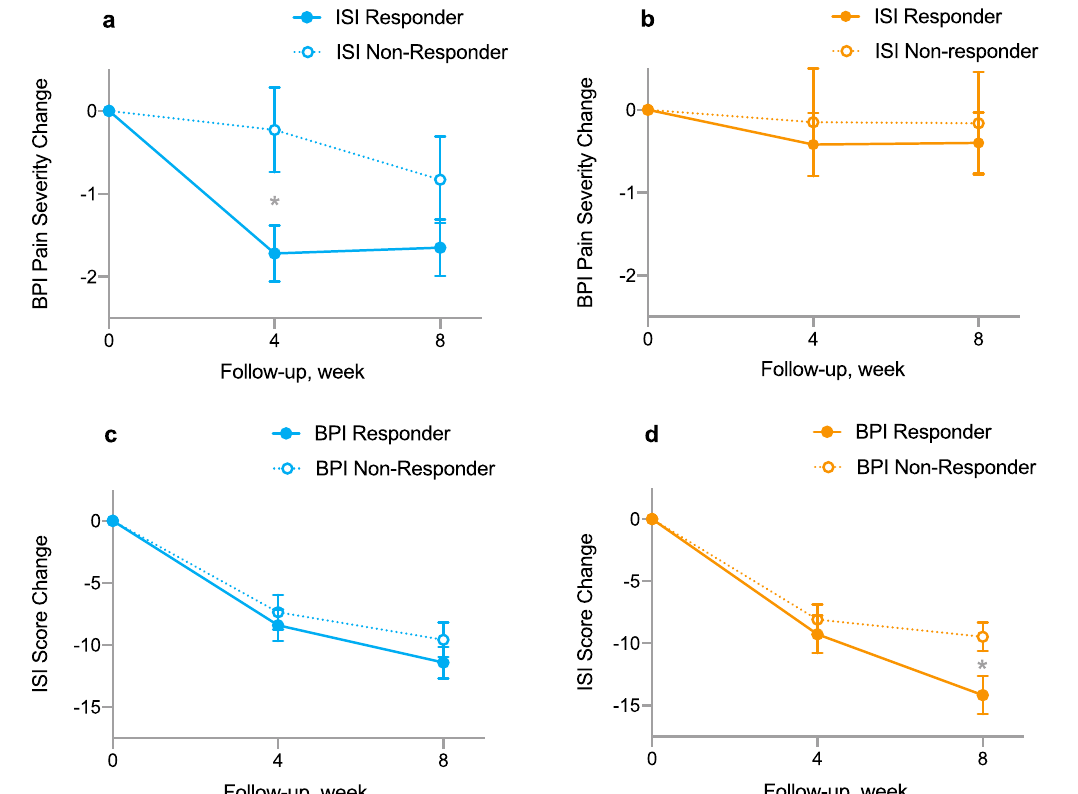
Fig. 3 Relationship between pain and insomnia in acupuncture and CBT-I. a Patients who responded to acupuncture treatment for insomnia at week 8 was associated with signi fi cantly greater pain reduction at week 4 as compared with non-responders; b No signi fi cant difference of BPI pain severity changes in ISI responder versus non-responder in CBT-I group at either week 4 or 8. c No signi fi cant difference in ISI score changes between BPI responder and non-responder in acupuncture group at either week 4 or 8; d BPI responders in CBT-I group had signi fi cantly more reductions in ISI score than BPI non-responders. Error bar indicates standard error of the mean. ISI Insomnia Severity Index, BPI Brief Pain Inventory, CBT-I cognitive behavioral therapy for